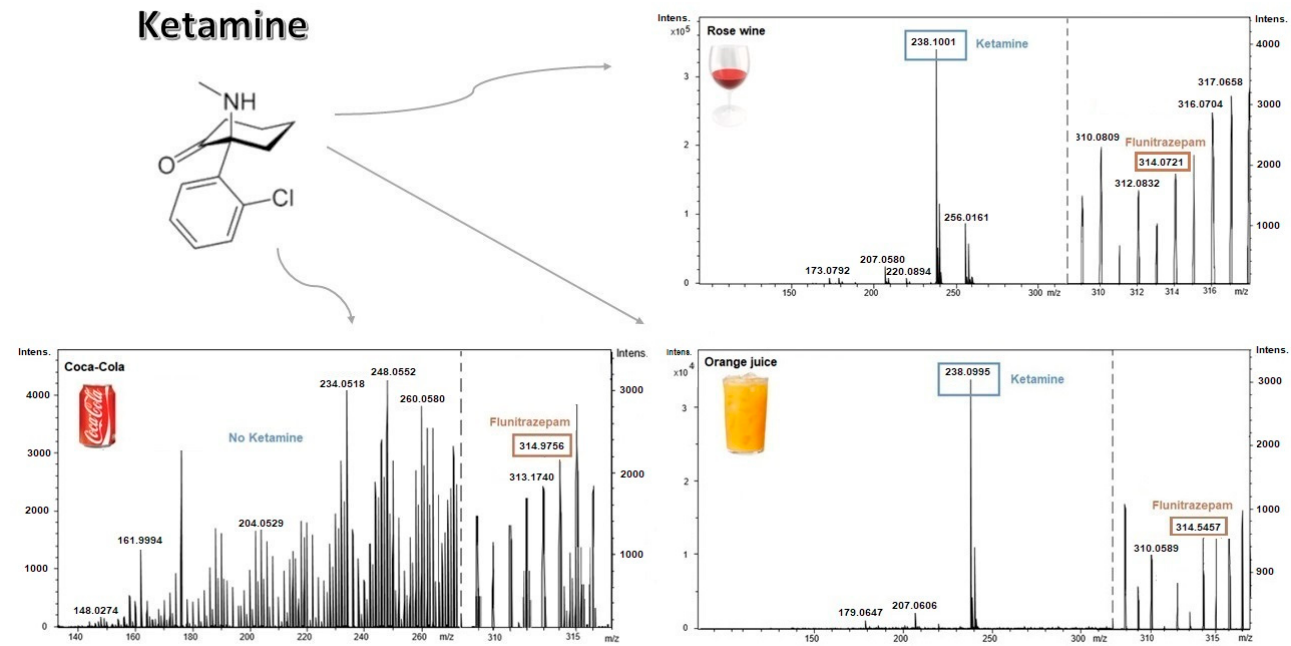
Figure 2. The mass spectra for the beverages—rose wine, orange juice, and Coca-Cola—containing ketamine.